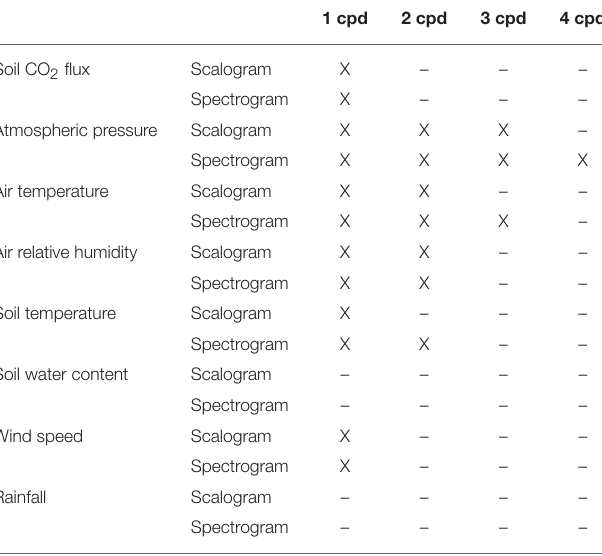
TABLE 3 | Identified daily cycles for the different monitored variables based on the two spectral methodologies. 1 cpd 2 cpd 3 cpd 4